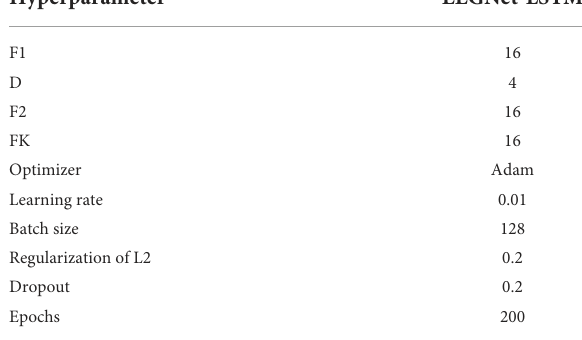
TABLE 6 Best selected hyperparameters for the EEGNet-LSTM decoder considering the data set Physiobank EEG Motion/Imagery from